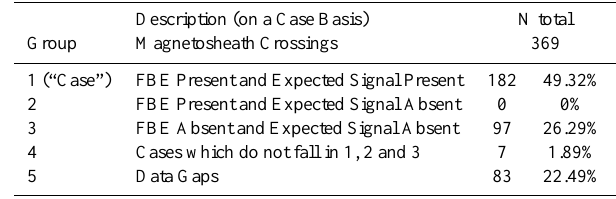
Table 1. Statistics for Flux Burst Events (FBE) determined in two years of Cluster Data. Expected Signal refers to either variability and/or depressed regions corresponding to the times of high energy particle flux. The “absence of FBE” refers to the times when FBE were not observed well within the magnetosheath, excluding those at the bow shock and magnetopause.